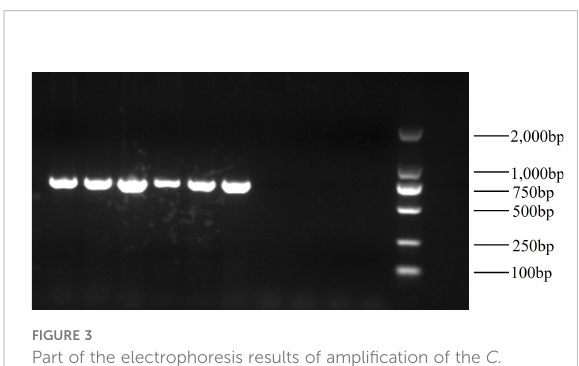
FIGURE 3 Part of the electrophoresis results of ampli fi cation of the C. tritonis COI